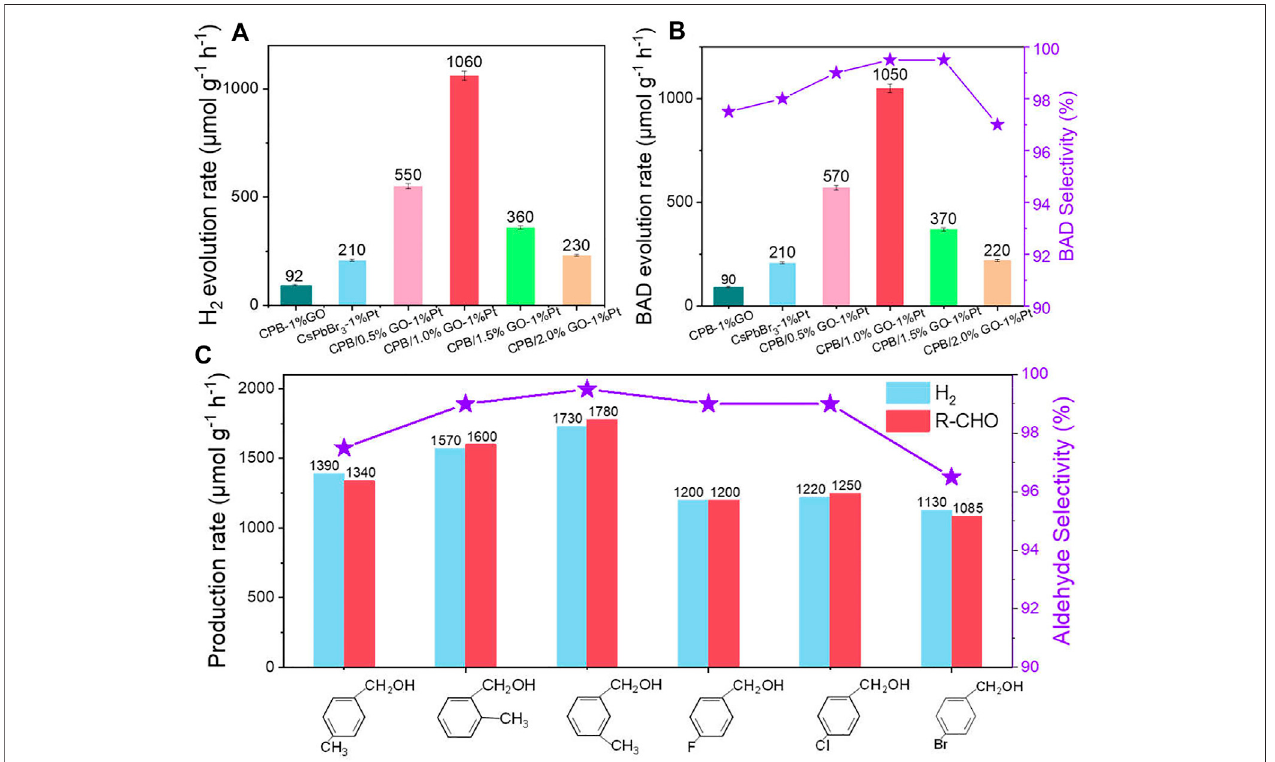
FIGURE3|(A) PhotocatalyticactivityofH 2 evolution, (B) BADevolutionandselectivityofCsPbBr 3 -1%PtandCPB/x%GO-1%PtwithdifferentweightratiosofGO. (C) ThephotocatalyticactivitiesforH 2 andaldehydegenerationofdifferentaromaticalcoholsusingCPB/1.0%GO-1%Ptasaphotocatalyst.Reactionconditions:10 mg catalyst, 1.0% Pt, 0.2 mmol BA, 3 ml of CH 3 CN, Ar atmosphere, and visible light ( λ > 400